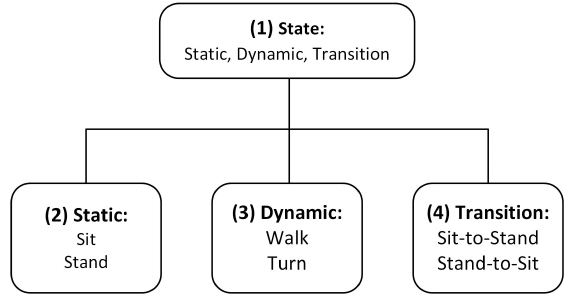
Figure 6. Hierarchical classification model. The first classifier distinguished between the state, and the others classify the possible activities of each